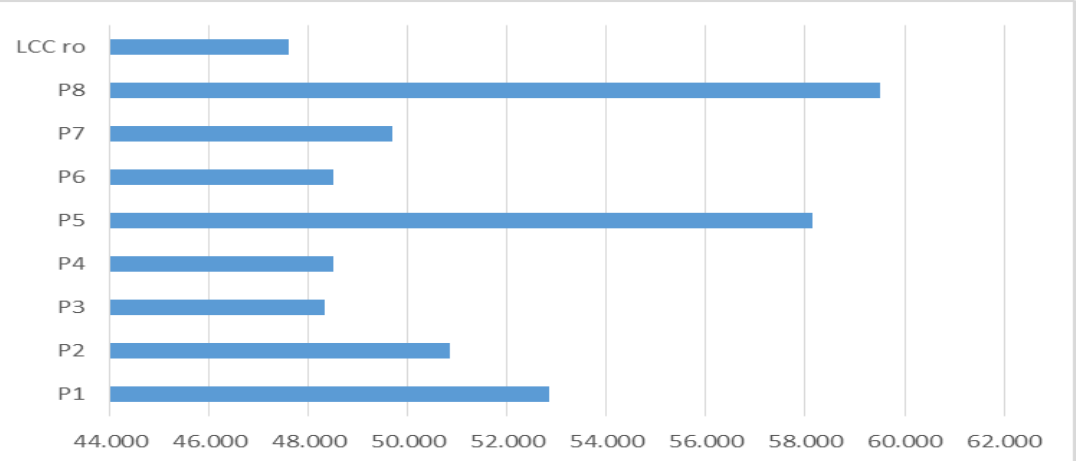
Figure 13. LCC at county level for the maximum scenario (bln.euro).